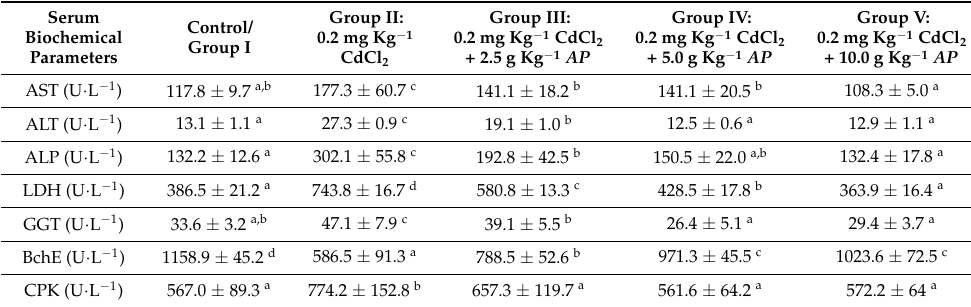
Table 3. Results on serum biochemical parameters. Serum